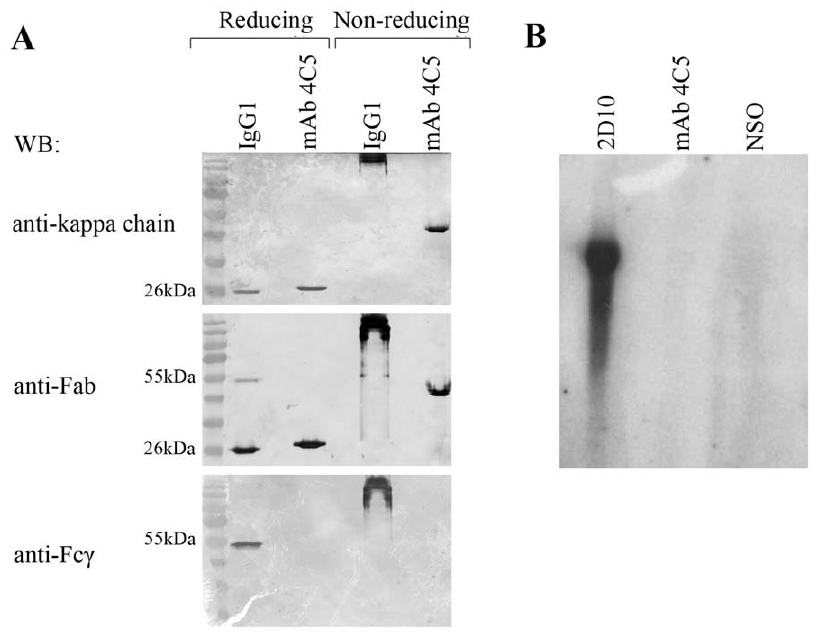
Figure 1. mAb 4C5 is a kappa L- chain dimer. A . Electrophoretic analysis of mAb 4C5, followed by immunoblotting with an anti-mouse kappa chain, an anti-mouse Fab and an anti-Fc c antibody. Intact IgG1 immunoglobulin produced by the2D10 hybridoma cells serves as positive control. Under reducing electrophoresis followed by western blot with the anti-Fab antibody, a single 25 kDa-immunoreactive band is observed, instead of the 25- and 50-kDa bands corresponding to the L- and H-chain, respectively, of an intact IgG1. This 25 kDa band is identical to the band corresponding to the kappa L-chain as shown by western blot with the anti-mouse kappa chain antibody. Under-non reducing electrophoresis followed by western blot with both the anti-kappa and the anti-Fab antibodies, mAb 4C5 is shown to migrate at approximately 50 kDa, and not at 150 kDa as expected for an intact IgG1 molecule. No mAb 4C5 immunoreactivity is detected after electrophoresis under both reducing and non-reducing conditions followed by western blot with an anti-Fc c antibody. In the case of the IgG1 immunoglobulin under the same conditions a 50 kDa and a 150 kDa band is observed, respectively. B . No radioactivity is detected after northern blot analysis of 4C5 hybridoma-derived RNA with a H-chain radiolabelled probe. RNA derived from the IgG1- producing 2D10 hybridoma cells and the NSO myeloma cells served as positive and negative control, respectively.